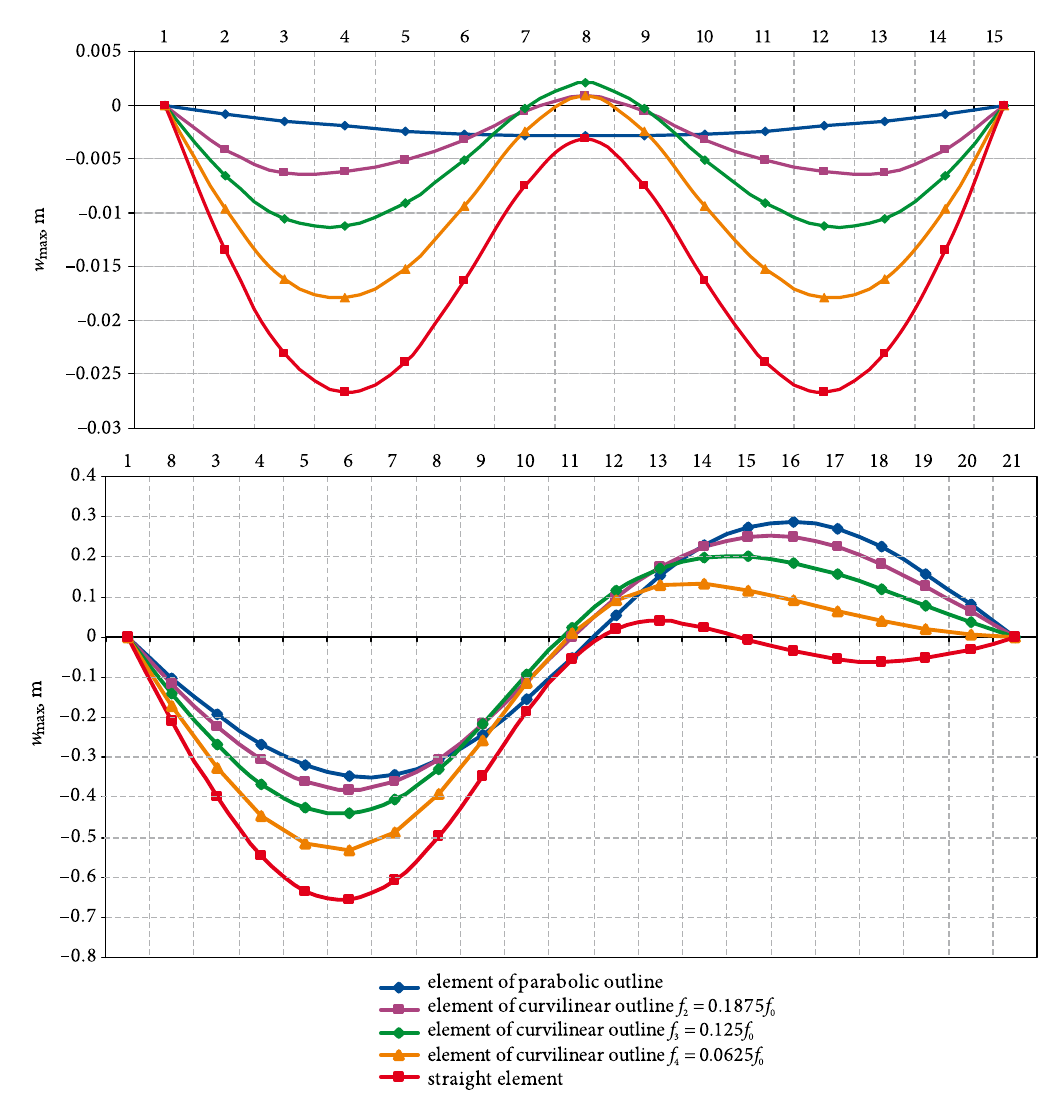
Fig. 13. Displacements of stiffening girder of suspension bridge with various initial shapes of the main cable under action of symmetrical (top) and unsymmetrical (bottom)